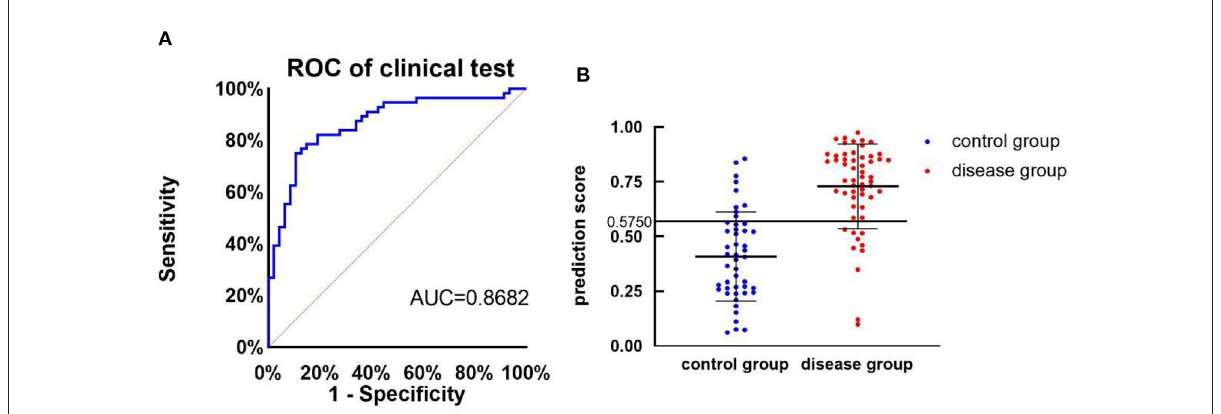
FIGURE2 The performance of depression classifier. (A) ROC curve of pre-training model of clinical test. (B) The prediction score of health controls ( n = 47, control group) and participants with major depressive disorder ( n = 56, disease group), AUC, area under the ROC curve, the cut-off is 0.5750 with the sensitivity is 82.14% and specificity is 83.64%.